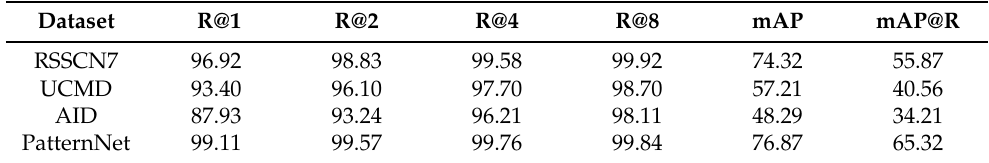
Table 9. Recall@K(%), mAP, and mAP@R performance for invisible classes on RSSCN7, UCMD, AID, and PatternNet. A total of 50% of classes were for training and the other 50% of classes were for testing.